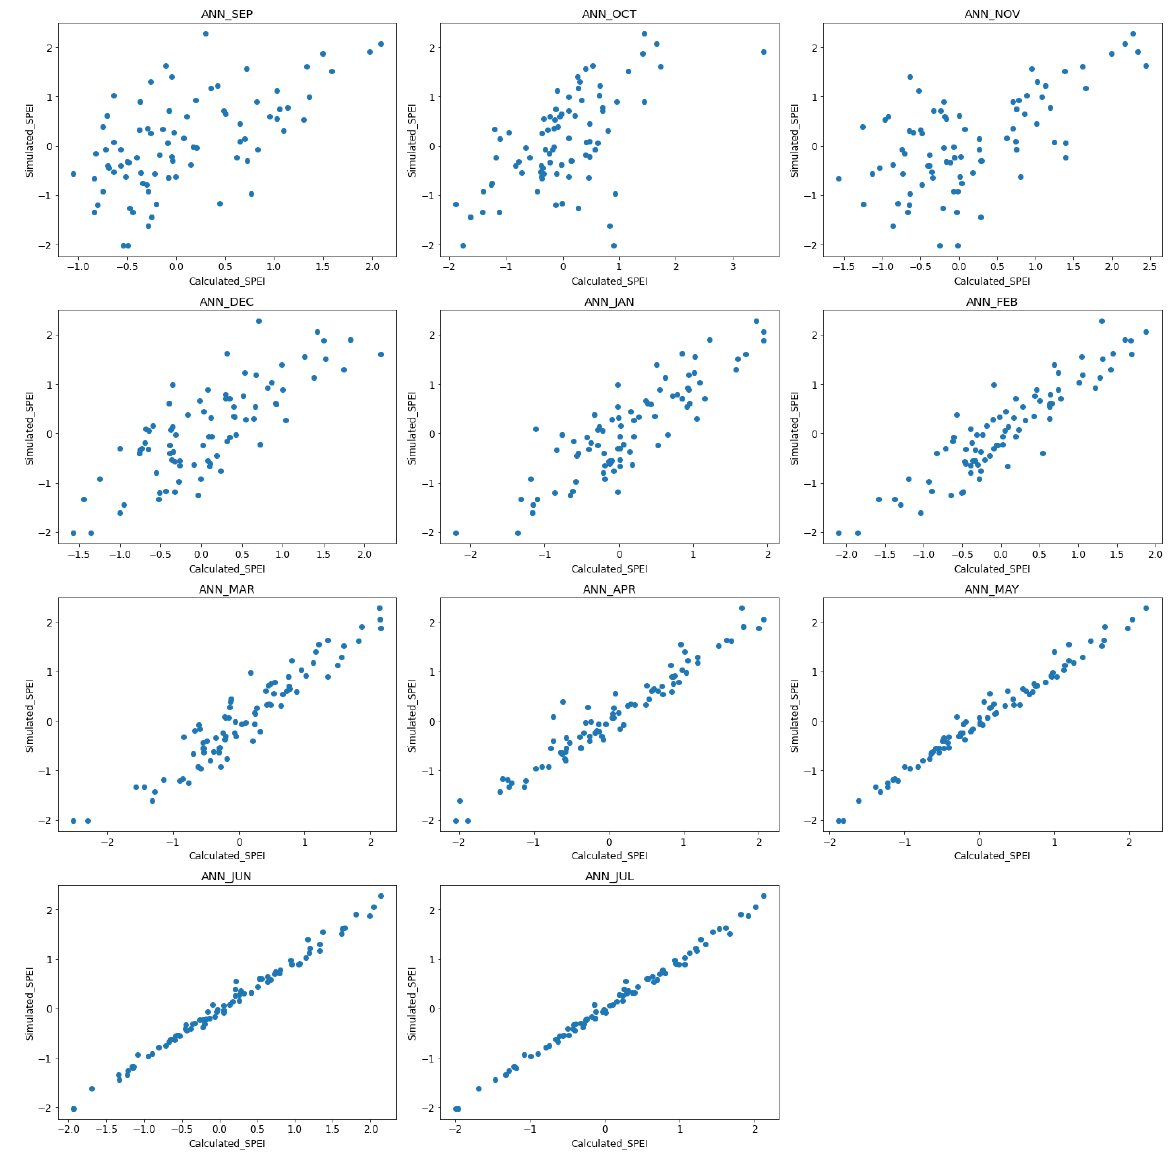
Figure 7. Scatter plots of observed vs.